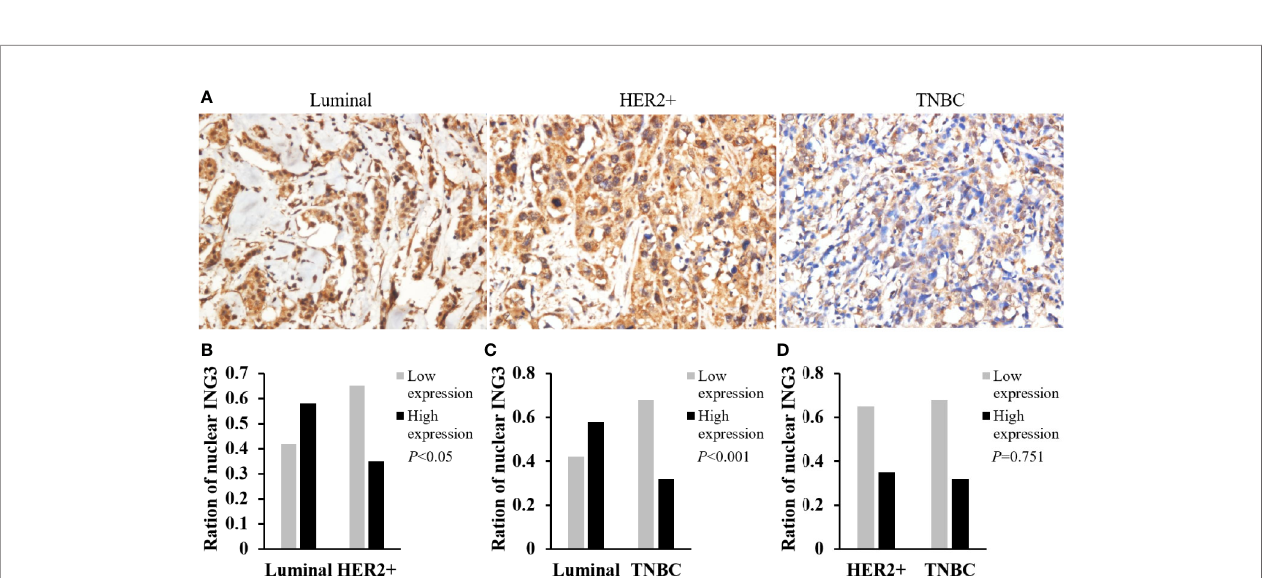
FIGURE 4 | Analyses of nuclear ING3 expression in breast cancer with different molecular subtypes. (A) The representative images of nuclear ING3 staining in different molecular subtypes. (A) Magni fi cation, ×400. (B – D) The c 2 test and Spearman ’ s rank result of nuclear ING3 staining in breast cancer with in different molecular